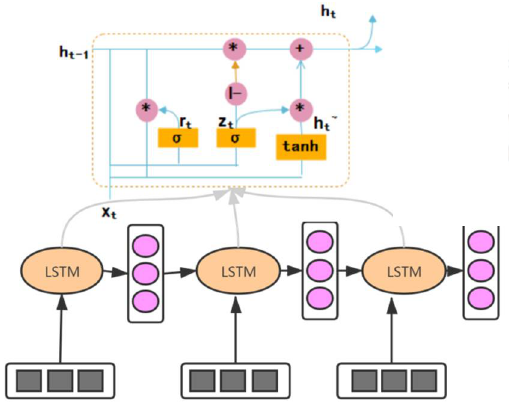
Figure 7. LSTM neural network structure.